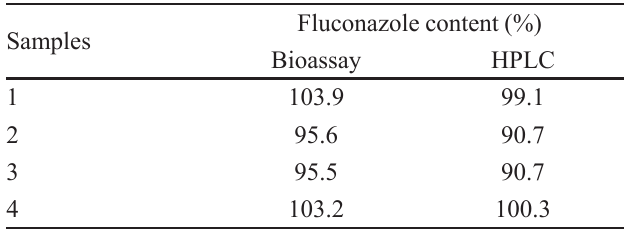
TABLE III - Fluconazole contents in capsule samples obtained by bioassay and HPLC